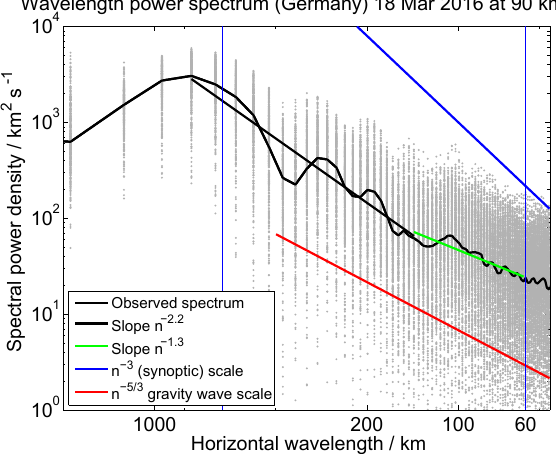
Figure 15. Horizontal wavelength spectra and estimated slopes to identify the transition from the mesoscale GW to the synoptic